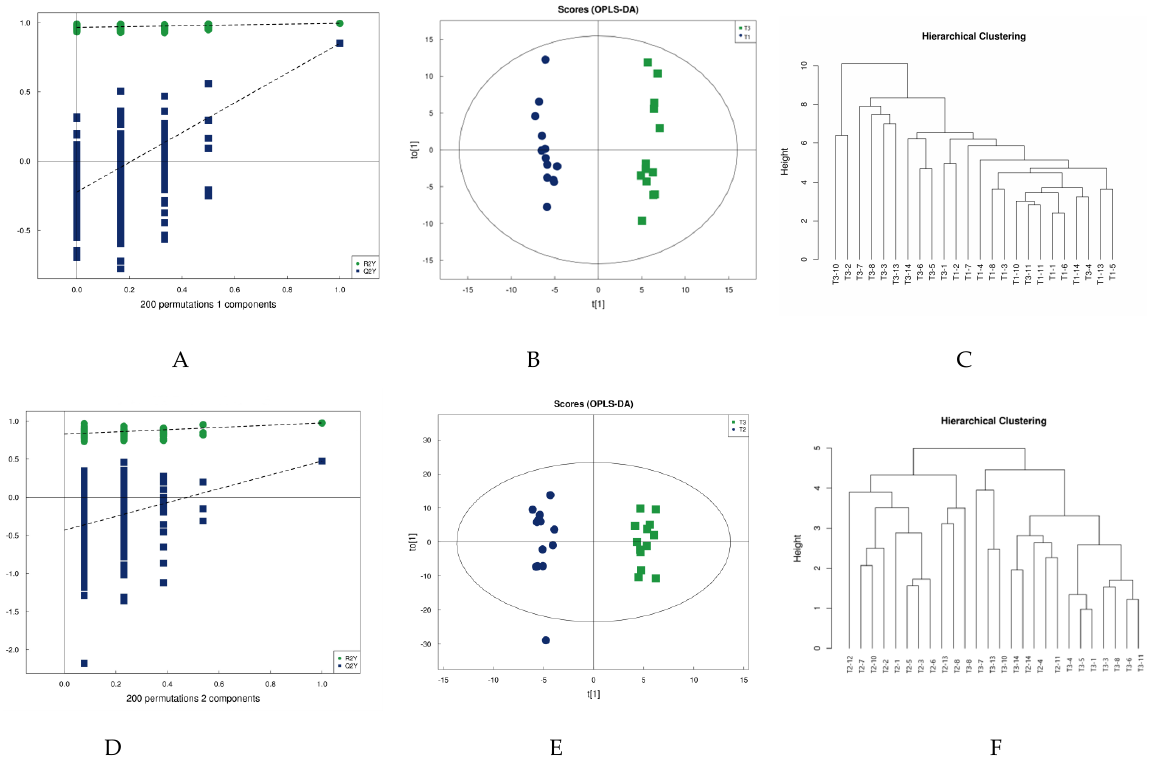
Figure 2. PLA-DA permutation test ( A , D ), OPLS-DA scores ( B , E ), and cluster analysis ( C , F ). Table 2. Model validation parameters between